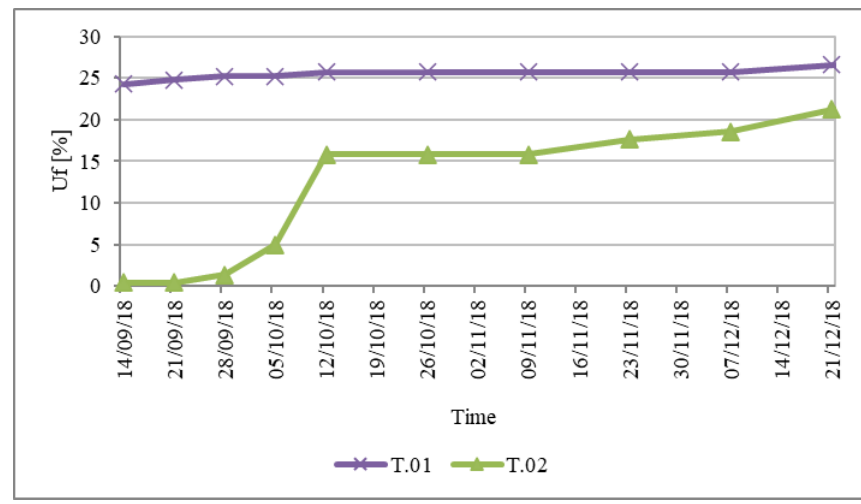
Figure 9. Moisture-time absorption curves for tuff blocks (T.).